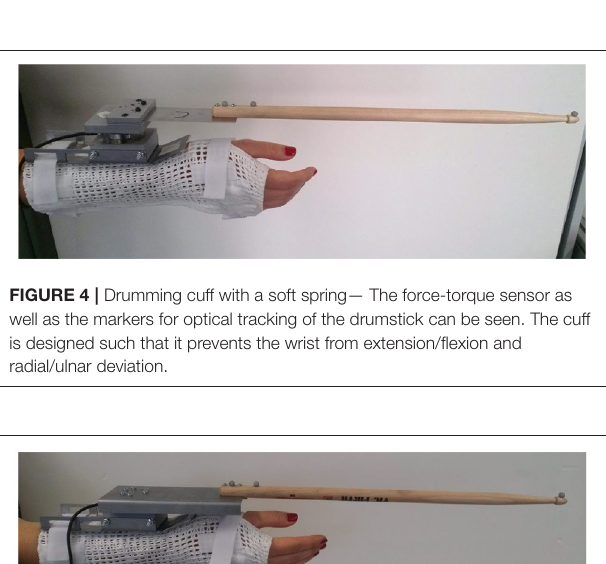
set to 0.5 times the desired time between strokes. Times between were counted as missed strokes or pauses and